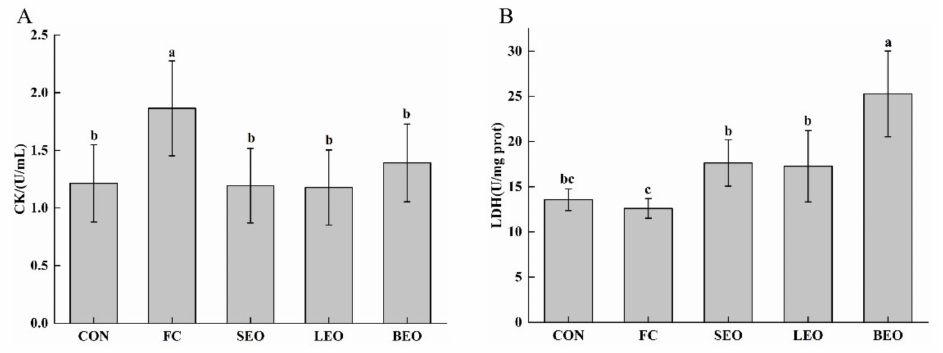
Figure 6. Effects of the inhalation of the CEOs on muscle injury in exercise-induced fatigue rats. ( A ) CK in serum, ( B ) LDH in gastrocnemius. Data are the means ± SD. Different lowercase letters indicate significant differences, p <